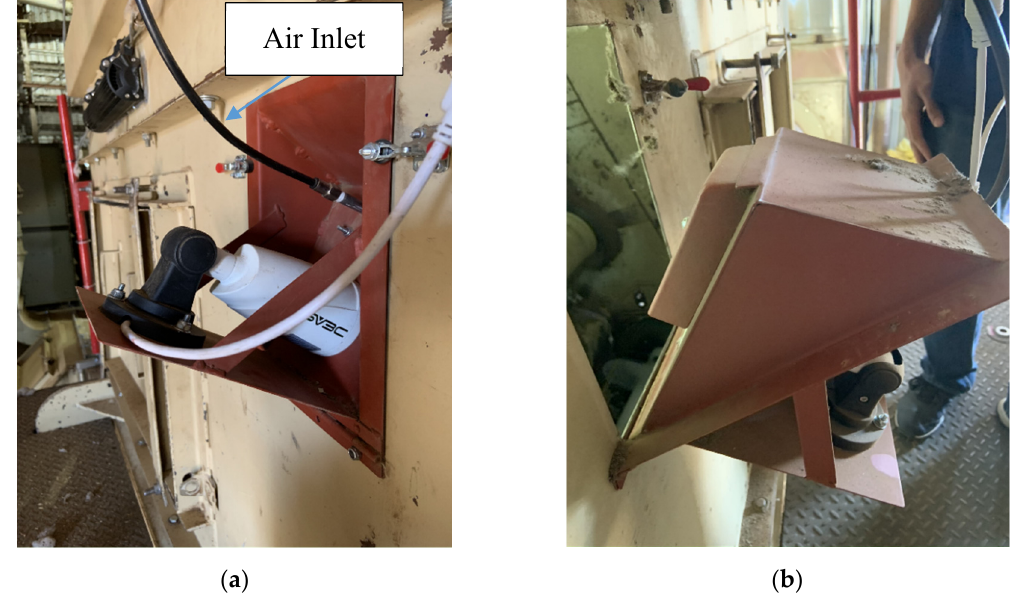
Figure 3. Second generation inspection camera and simplified housing, that relies on external lights.